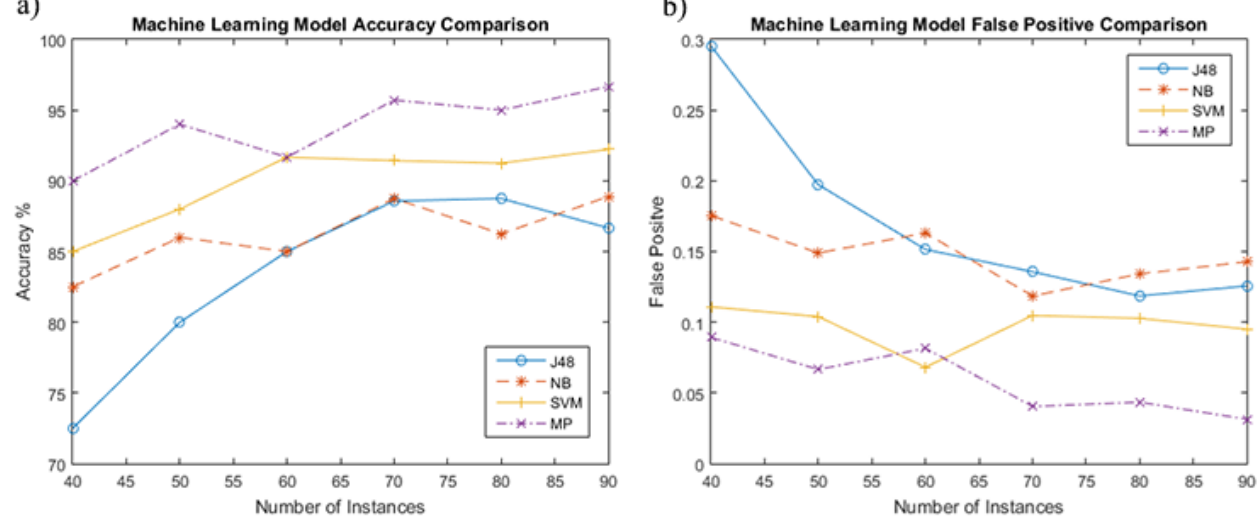
Figure 8. (a) Accuracy of each machine learning model with different number of instances. (b) Evaluation of false positive rate for different machine learning